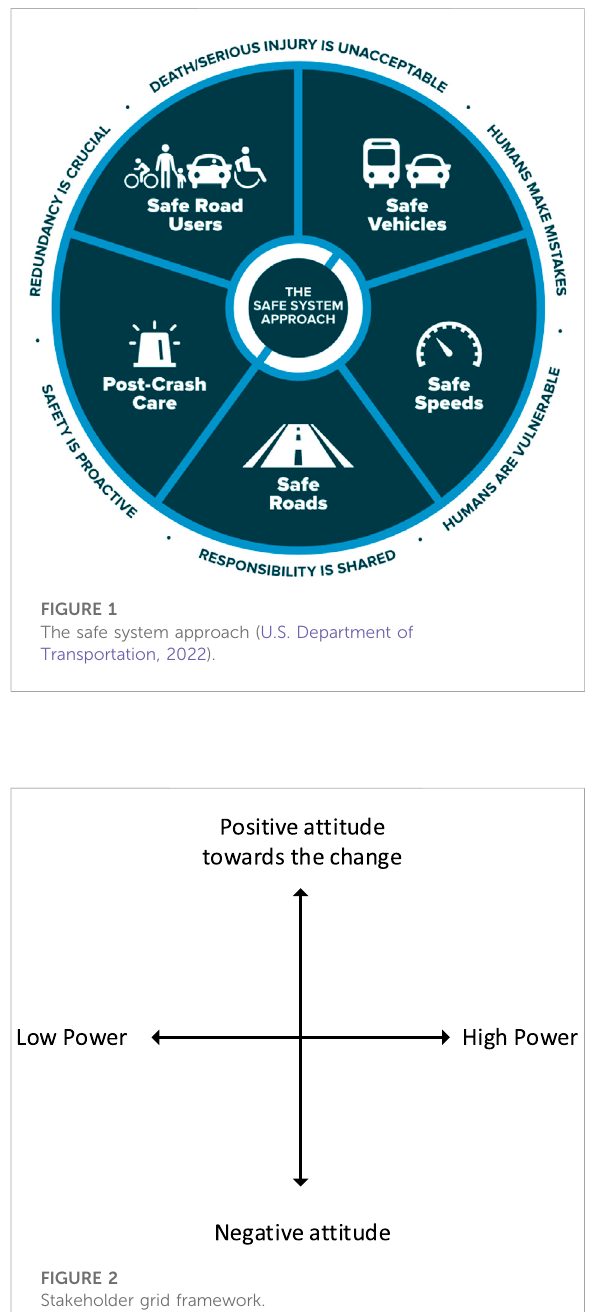
FIGURE 2 Stakeholder grid